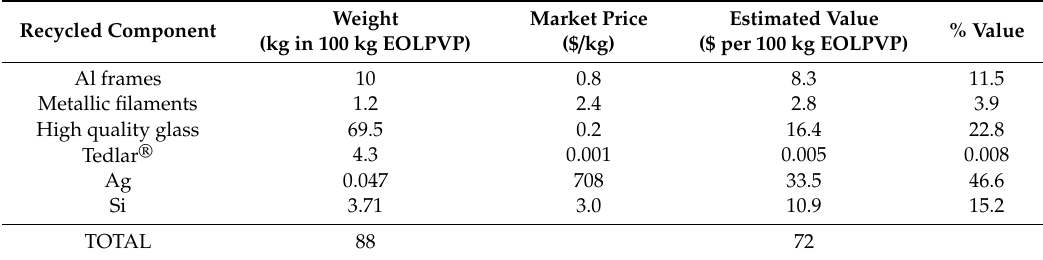
Table 3. Recycling rate, recovery rate, amount of wastes produced, and recoverable value according to mass balances for the PhotoLife process.